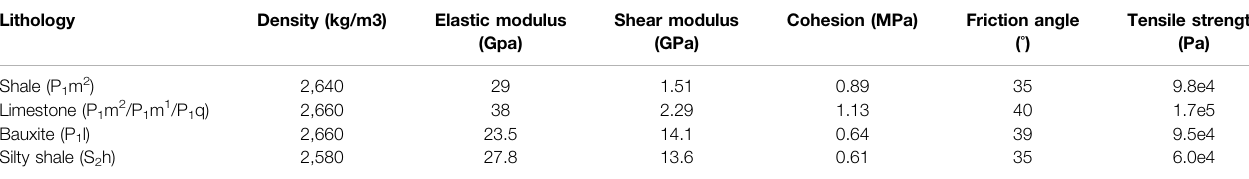
TABLE 4 | Physical – mechanical parameters of the rock mass used in the numerical models.